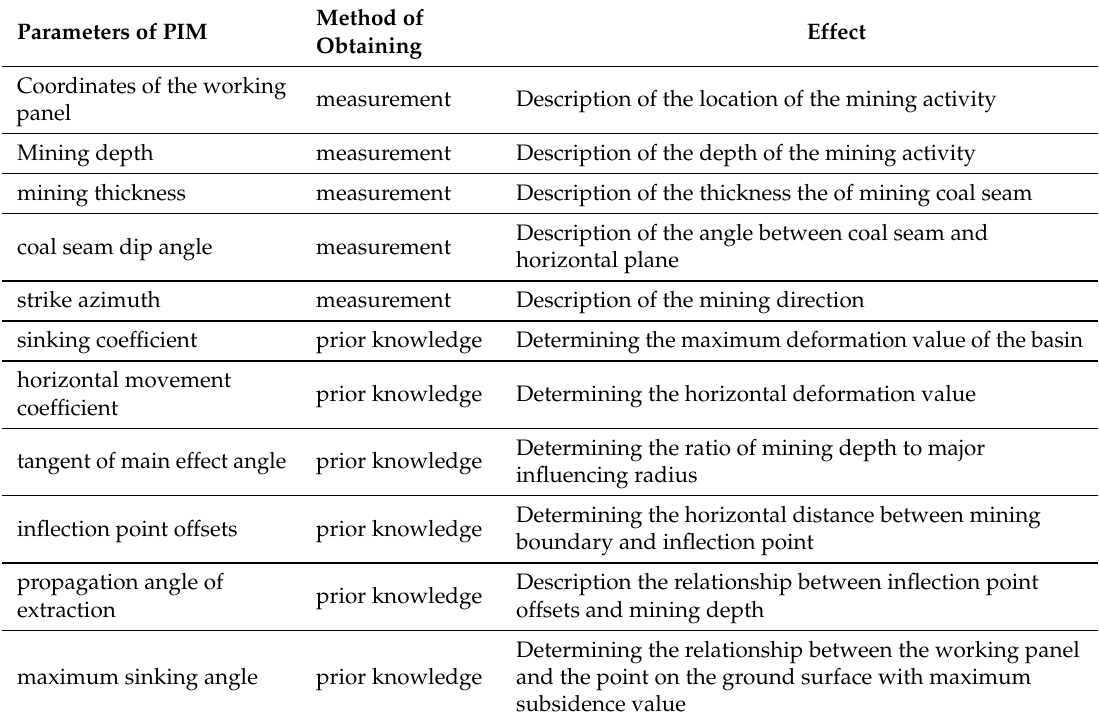
Table 1. Obtaining method and effect of Probability Integration MEthod (PIM)